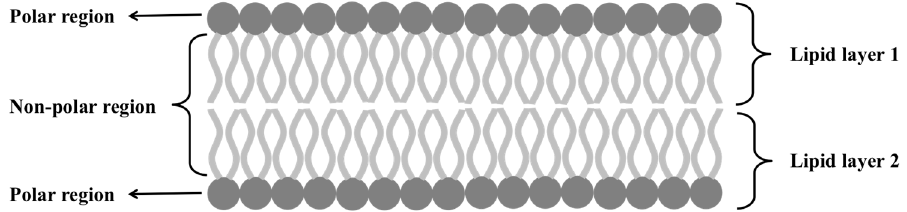
Figure 3. Structure of cell membrane showing the arrangement of hydrophobic (non-polar) and hydrophilic (polar) regions of phospholipid bilayer.